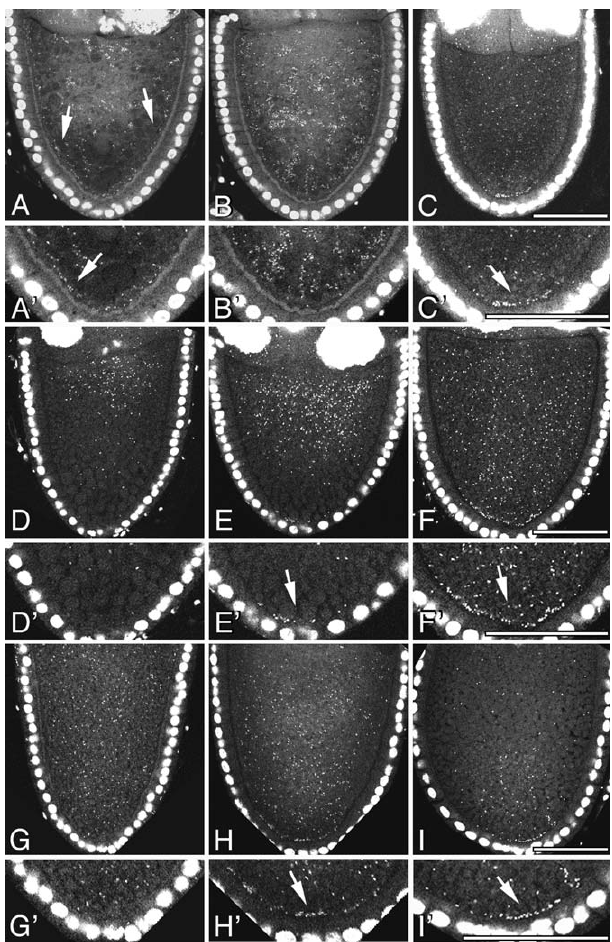
Figure 2. Effect of Microtubule, Kinesin-1, and osk Disruptions on wMel Posterior Localization Stage 10A wMel -infected oocytes are shown with propidium iodide labeling. (A–I) Full-size images are accompanied by (A’–I’) corresponding expanded views of the oocyte posterior pole. Conditions shown: (A, B) colchicine-DMSO-treated, (C) DMSO-treated, (D) Khc 27 , (E) Khc 23 , (F) Khc 27 / þ , (G) osk 54 /oskDf (3R)p-XT103 , (H) osk 54 / þ , (I) oskDf (3R)p-XT103 / þ . Arrows indicate enrichment of wMel at the (A) lateral and (A’, C’, E 9 , F’, H’, I’) posterior cortex of the oocyte. Scale bars ¼ 25 l